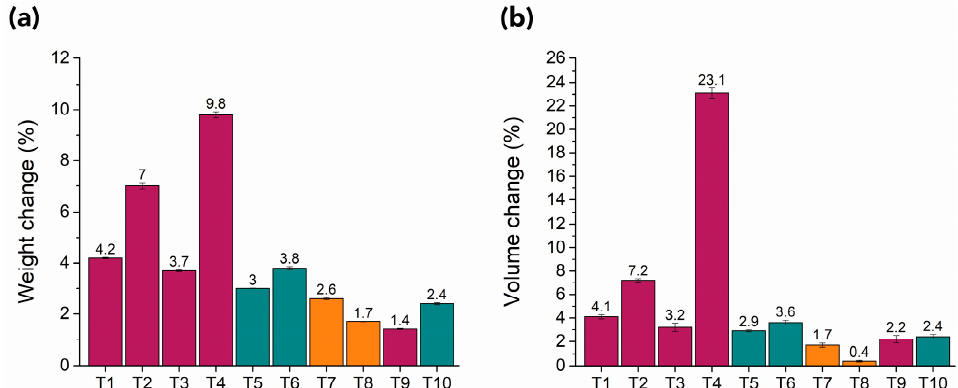
Figure 3. Average and standard deviation values for changes in ( a ) weight and ( b ) volume for PMMA samples treated with CO 2 at different conditions (supercritical: purple bars; liquid: blue bars; vapor: orange bars), measured approximately 2 h after tests.